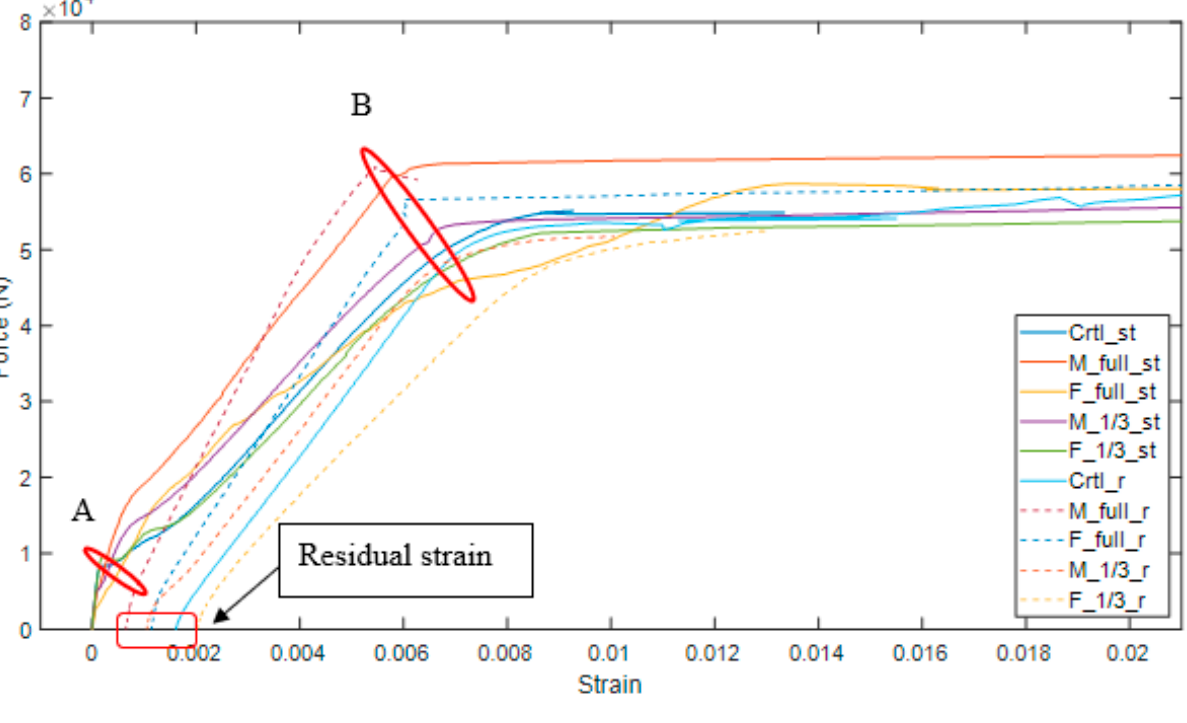
Figure 9. Load vs. strain of steel